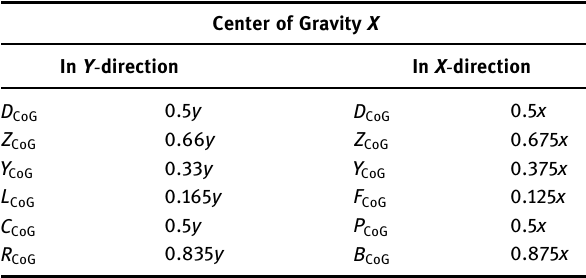
Table 2: Relative position of the centers of gravity over the vehicle length X and width